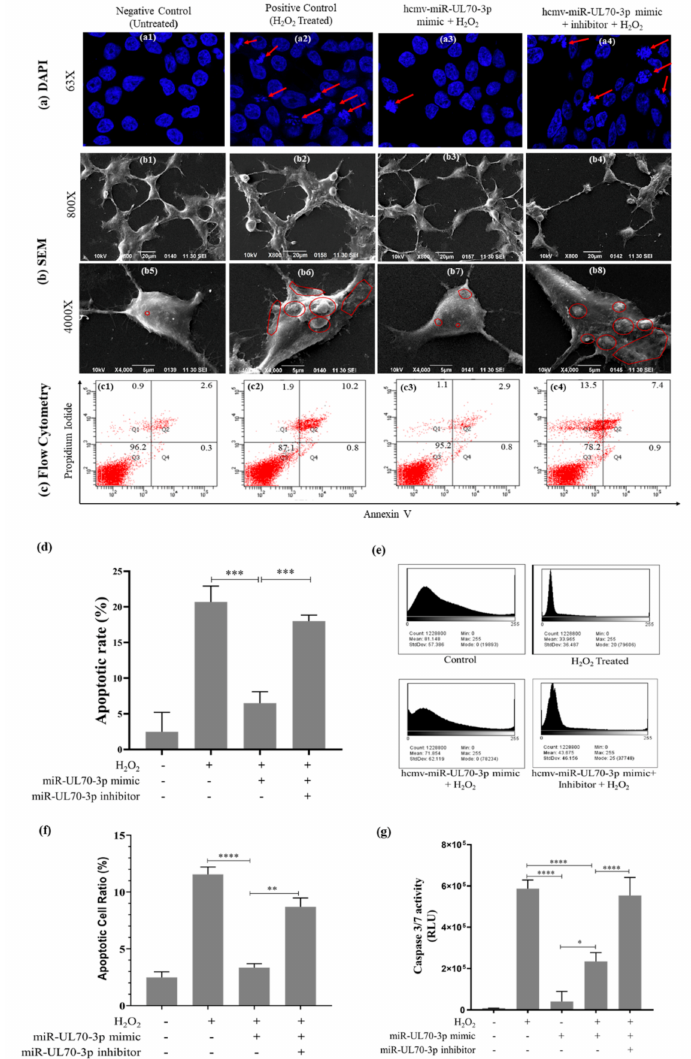
Figure 1. Effect of hcmv-miR-UL70-3p on H 2 O 2 -induced apoptosis. HEK293T cells were divided into four different groups to evaluate the effect of hcmv-miR-UL70-3p on H 2 O 2- induced apoptosis, 1st group as negative control (untreated); 2nd group as positive control (treated with H 2 O 2 only); 3rd group is transfected with hcmv-miR-UL70-3p mimic followed by H 2 O 2 treatment, and the 4th group is transfected with hcmv-miR-UL70-3p mimic along with its inhibitor followed by H 2 O 2 treatment. ( a ) Representative images showing the nuclear morphology of different groups of cells (63 × ) after DAPI staining. The apoptotic nuclei were indicated through red arrows in ( a1 – a4 ). The × 100 apoptotic rate was calculated using the equation Apoptotic Rate ( % ) = Number of apoptotic Nuclei Total number of Nuclei and is shown in ( d ) ( ± SEM; ***, p <0.001). Data from three independent experiments were used for statistical analysis, ( ± SEM; ****, p < 0.0001). ( b ) SEM images of different cell groups taken at 800 × and 4000 × , and the membrane blebbing/rufflings are marked in red lines ( b1 – b8 ). The 800 × images ( b1 – b4 ) were used in generating the histograms showing the mean cell surface coverage area through ImageJ Software ( e ). The representative dot plots showing live and apoptotic cells determined by flow cytometry are arranged in ( c ). ( f ) shows the apoptotic cell ratio for flow cytometric analysis, data from three independent experiments were used for statistical analysis ( ± SEM; **, p < 0.01; ****, p < 0.0001). ( g ) Caspases 3/7 activity measurements were plotted as RLU, and the data from three independent experiments were used for statistical analysis ( ± SEM; *, p < 0.05; ****, p <